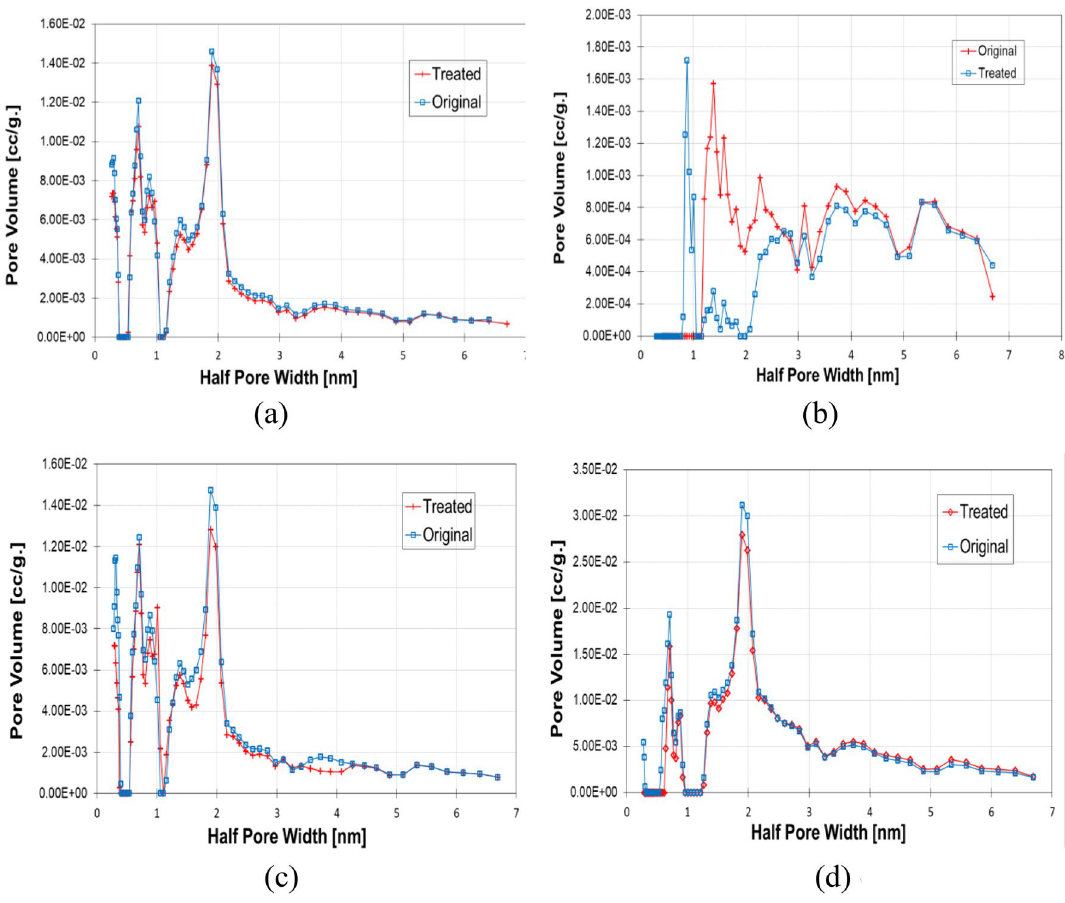
Figure 6. Pore size distribution comparison before and after treatment. ( a ) Haynesville Shale. ( b ) Eagle Ford Shale. ( c ) Longmaxi Shale. ( d ) Opalinus Shale.